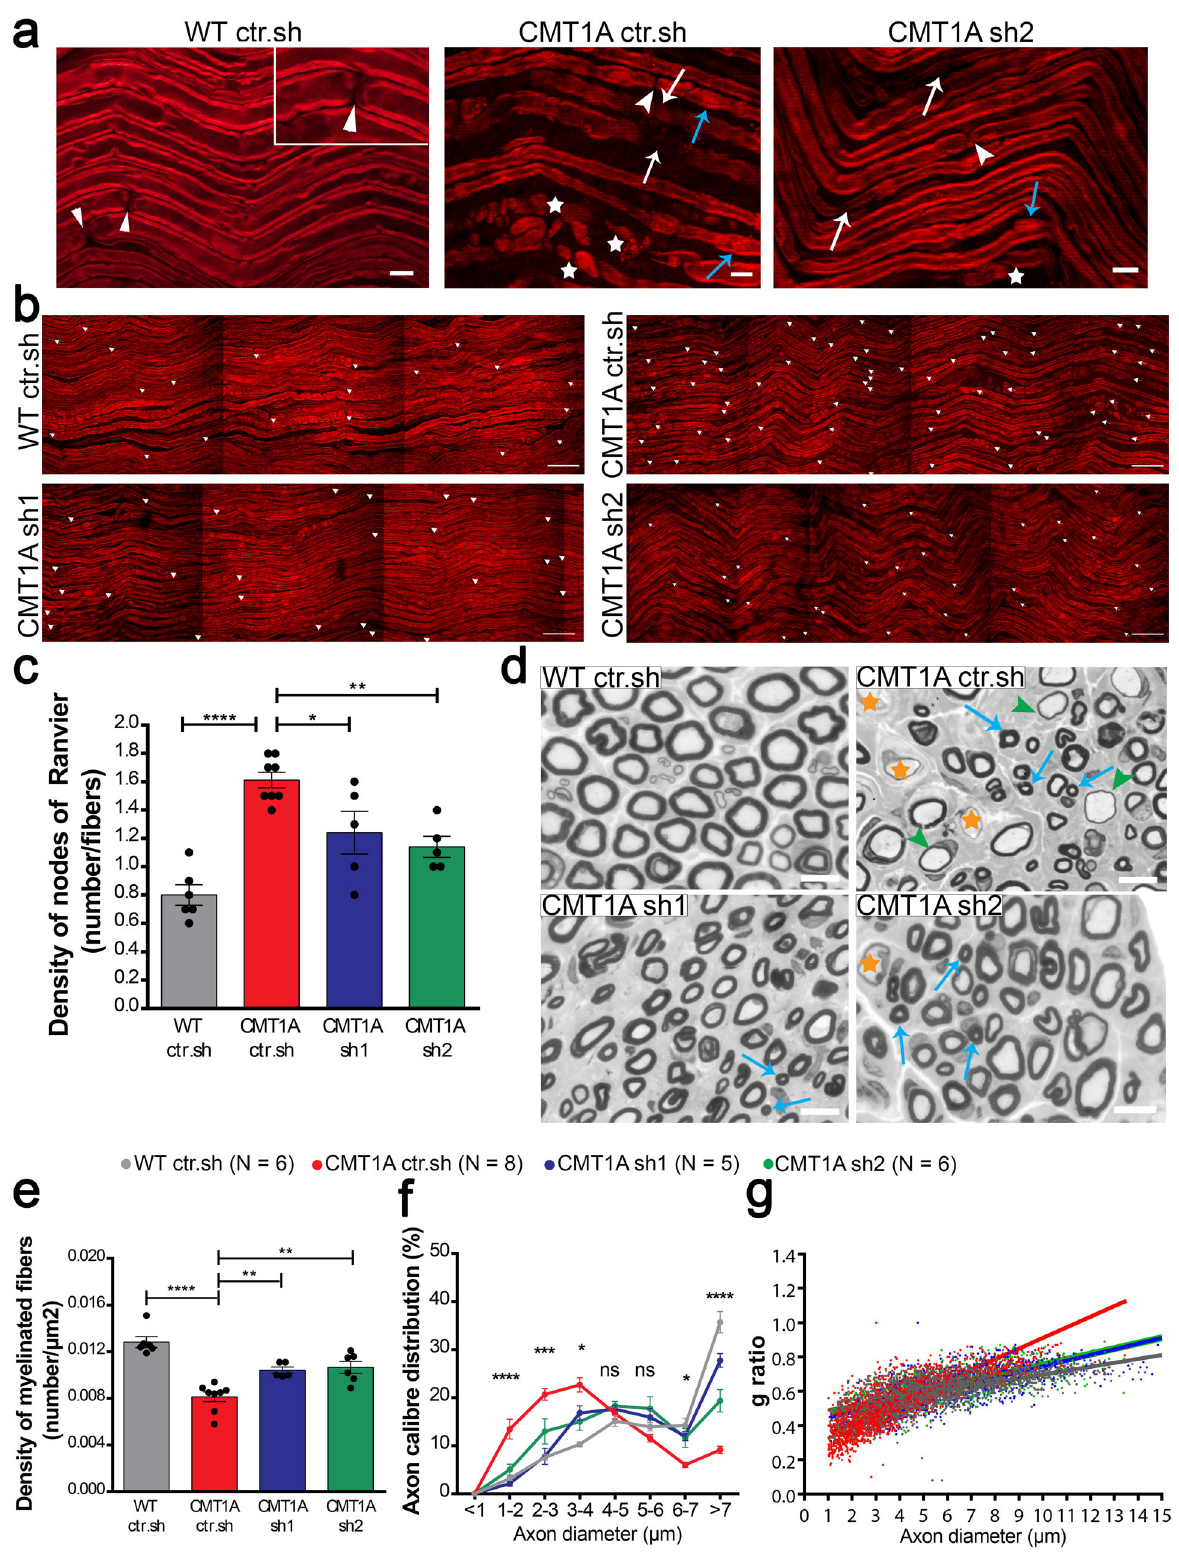
robustly cover the 3 most relevant biomarkers (Fig. 6b). Taken together these data indicate that a combinative score grouping functional tests and skin biomarkers analysis constitute a reliable and robust measure of CMT1A gene therapy outcome in CMT1A